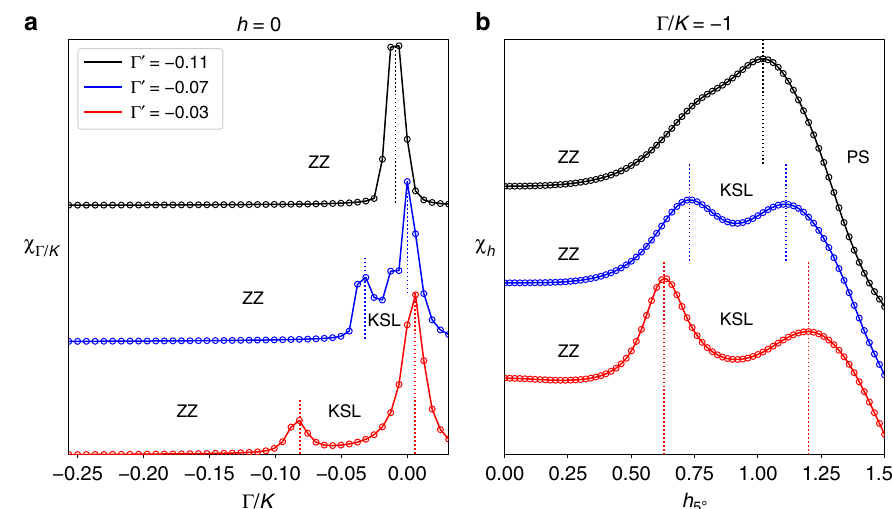
Fig. 3 Effect of Γ ′ on the intermediate phase. The role of Γ ′ is illustrated through cuts of the susceptibilities for increasing values of | Γ ′ | as calculated with ED on a 24-site honeycomb cluster. a The susceptibility χ Γ / K is shown at h = 0 near the Kitaev limit for Γ ′ = − 0.03, − 0.07, and − 0.11. Peak values of χ Γ / K are scaled to the same number and are offset for visibility. With increasing | Γ ′ | the ZZ phase is seen to expand as the KSL shrinks, and the KSL disappears ’ (cid:4) 0 : 1. b The magnetic susceptibility χ h is shown for a 5° tilted fi eld at Γ / K = − 1 where the intermediate phase is largest for Γ ′ = entirely beyond Γ ′ c − 0.03. Values of χ h are not scaled, but simply offset for visibility. A similar trend is found where the size of the intermediate phase shrinks with increasing | Γ ′ |. The intermediate KSL disappears beyond Γ